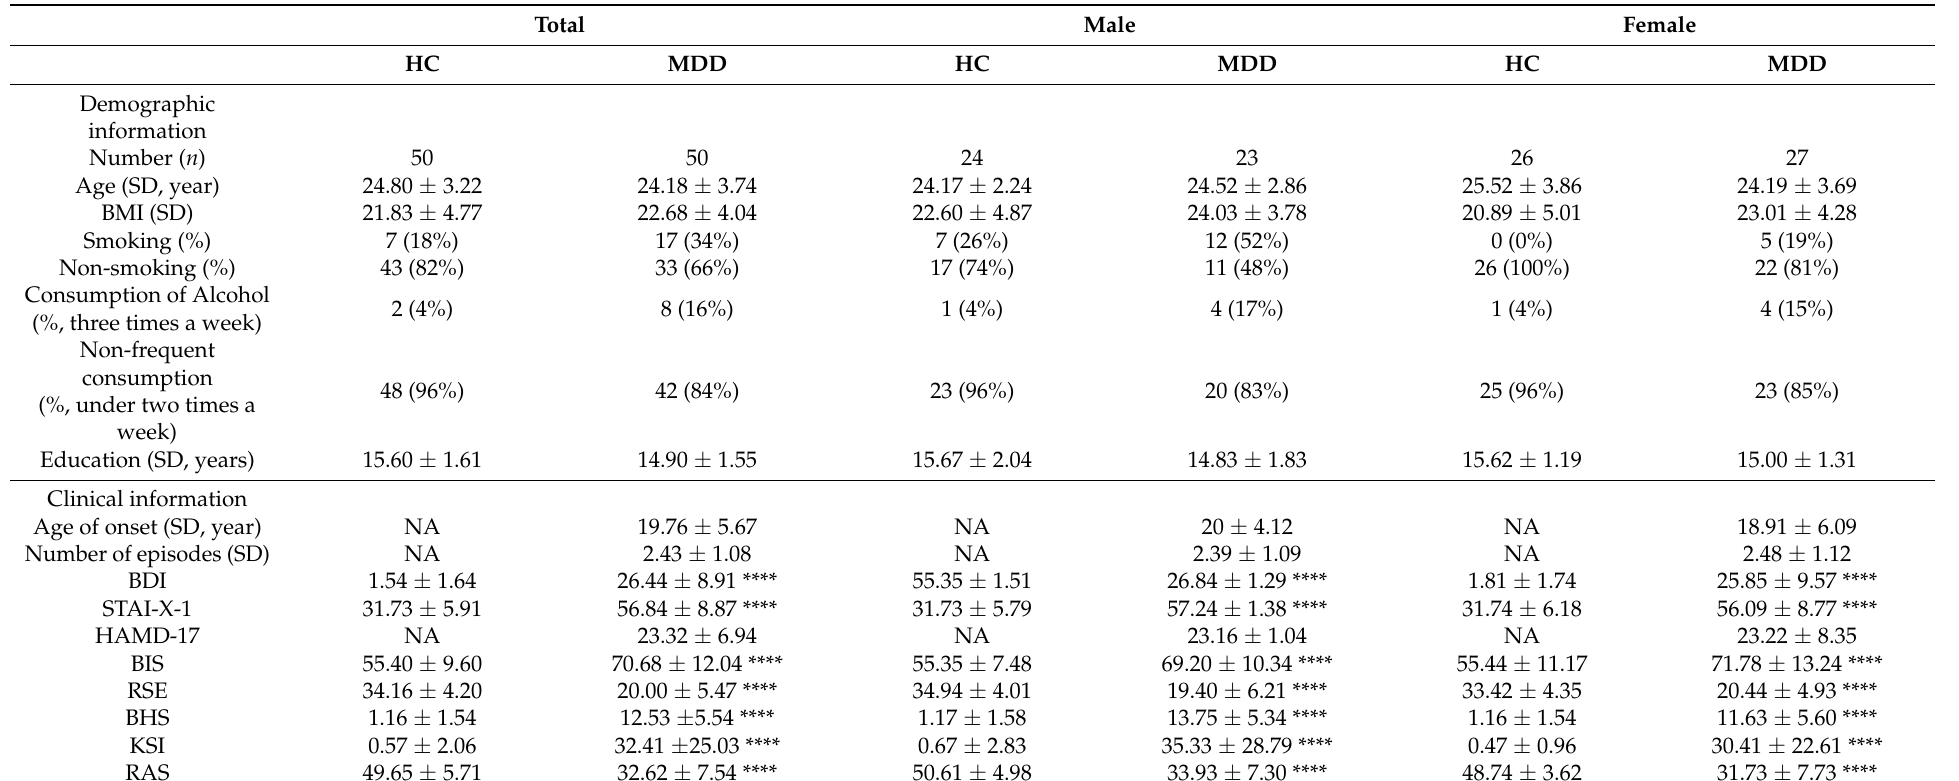
Table 1. Baseline demographic and clinical